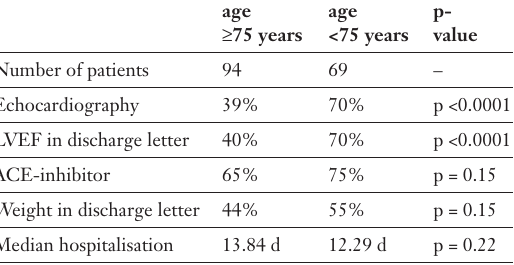
Results in the CHF